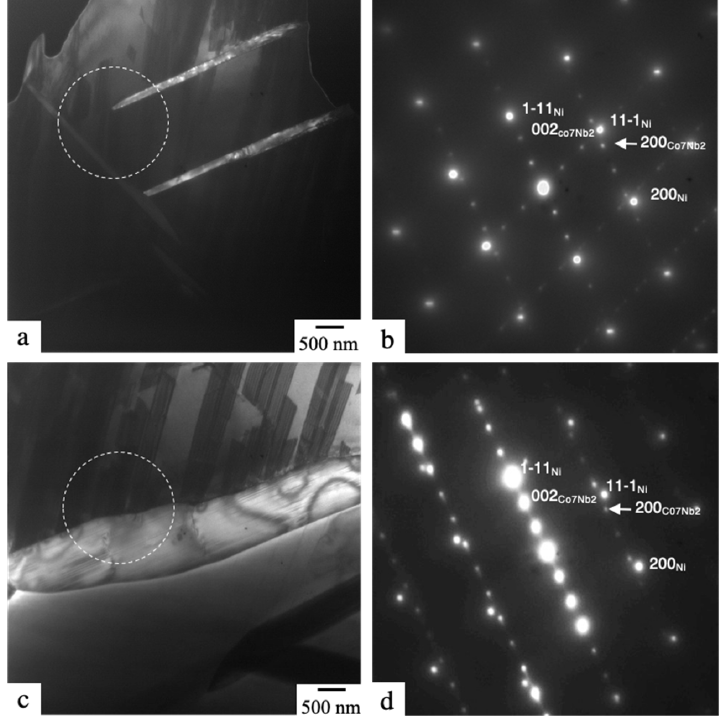
Figure 2. TEM images of Ni-5Nb-80Co after solution treatment followed by aging at 1273 K for 100 h: ( a ) dark-field image taken with g = 001 Co7Nb2 ; ( b ) selected-area diffraction pattern (SADP) corresponding to the area indicated by a dashed line in ( a ); ( c ) bight-field image taken with B = 110 Ni ; and ( d ) SADP corresponding to the area indicated by a dashed line in ( c ).